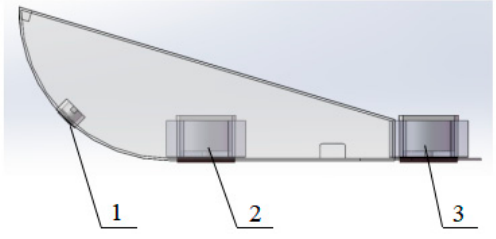
Figure 5. Pressure sensor installation location. Figure 6. Pressure sensor installation location (Side view). 1. Forward resistance sensor. 2. Front pressure sensor. 3. Rear pressure sensor.